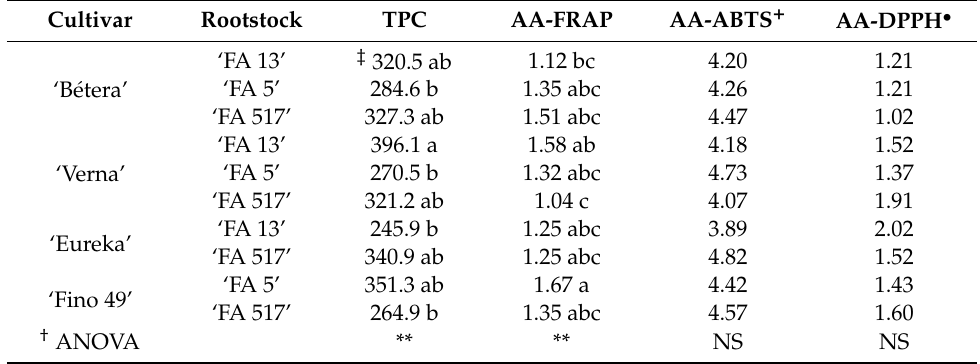
Table 5. E ff ect of di ff erent rootstocks on lemons (‘B é tera’, ‘Verna’, ‘Eureka’ and ‘Fino’ 49) fruit total polyphenols content (TPC, mg GAE 100 mL − 1 ), and total antioxidant activity measured according